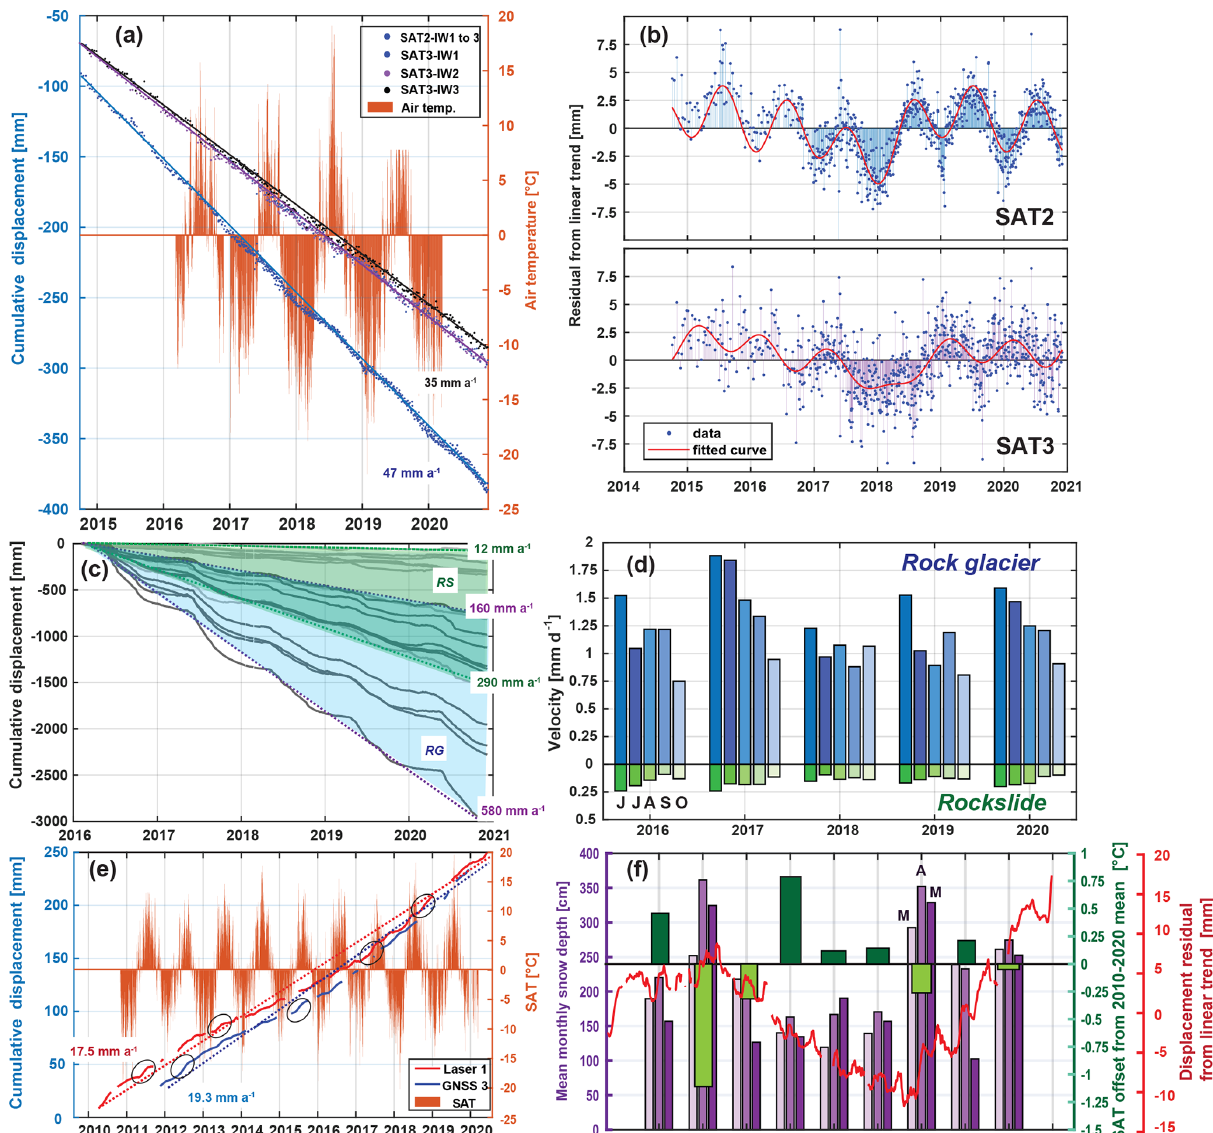
Figure 5. Displacement measurements at Gámanjunni-3 (a–d) and Mannen (e, f) . (a) Cumulative displacement rates from the three satel- lite corner reflectors on Gámanjunni-3, showing average annual displacement rates between 35 and 47mma − 1 along satellite radar LOS. (b) Residuals from the linear trend for SAT2 (upper) and SAT3 (lower). We fitted a third-order sinusoidal curve (red line) to the residual points. The fit indicates annual variation and a trend towards negative residuals until 2018. (c) Cumulative displacement along GB radar LOS derived at a total of 18 points dispersed over the rockslide (RS) and rock glacier (RG) area (Fig. 1) based on GB InSAR. The green shaded envelope shows the RS points, and the light blue envelope indicates the RG points. Velocities between 10 and close to 600mma − 1 are encountered. (d) Average daily displacement averaged over a month along GB radar LOS for one GB InSAR point at the rock glacier (blue bars) and a point at the rockslide area (green bars). For each year the months between June and October are shown. The graph shows the highest velocities early in the melting season and the highest absolute velocities in 2017. (e) Mannen: cumulative displacement rates for GNSS3 and Laser1, plotted with SAT since 2010. There are obvious acceleration phases (some indicated by ellipses) during early summer (May–June). (f) Residuals from the linear trend for Mannen Laser1 (red line) against MAAT deviation between 2010 and 2020 (green bars) as well as snow depth (purple bares) for the months March through May. There is a clear decrease in displacement rates between 2013 and 2017, which seems to be related to higher air temperatures and lower snow